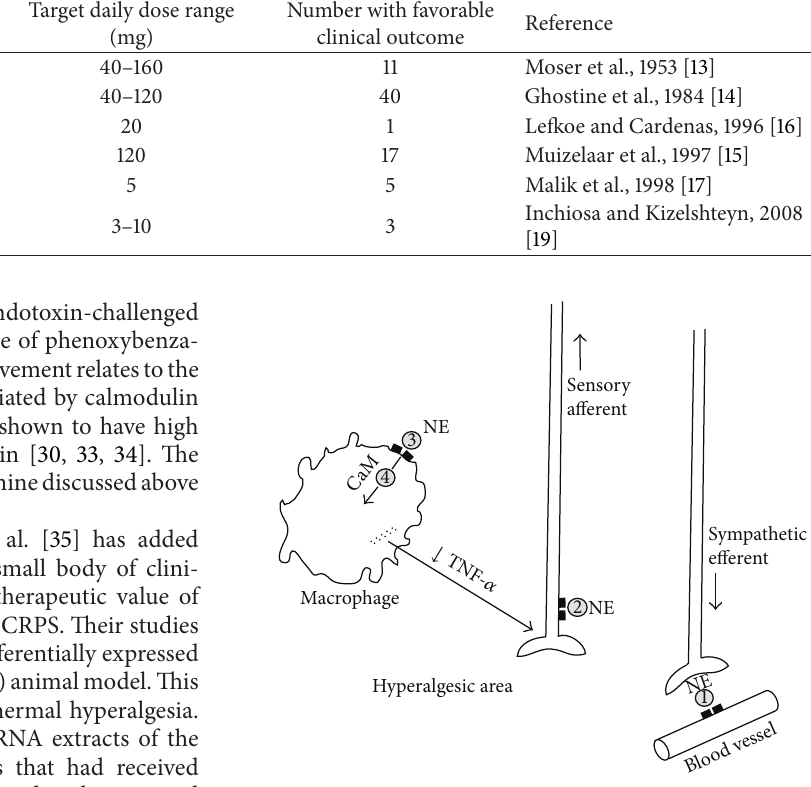
Figure2:Depictionofpossiblesitesofactionofphenoxybenzamine in the suppression of neuropathic pain. Site 1) Blockade of nore- pinephrine (NE) effects on 𝛼 1 -adrenergic receptors on blood vessels, thereby promoting vasodilation; Site 2) blockade of adrenergic receptorsthatpopulateafferentsensoryfibers;Site3)blockadeof 𝛼 2 - adrenergic receptors on the surface of macrophages, which appear to mediate release of proinflammatory cytokines, including tumor necrosis factor- 𝛼 (TNF- 𝛼 ); Site 4) inhibition of calmodulin (CaM), which is involved in the cytokine-release process. (Schematically based on Figure 4 of J¨anig and Baron, 2003; [23] reproduced with permission from Pain Practice, 2008